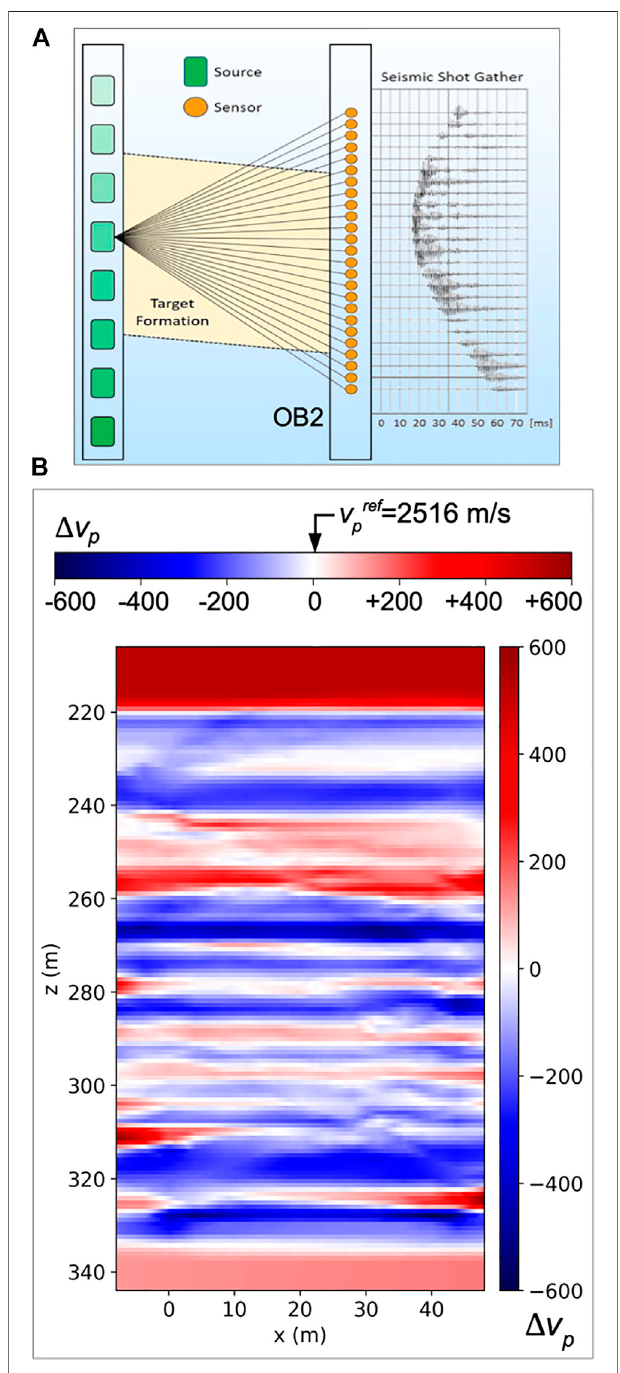
FIGURE 3 | (A) : Schematic view of crosswell seismic system. (B) : 2D v p -imageresultingfromCaMI.FRSseismic fi elddatainversion.Shownvelocity anomalies Δ v p are with respect to the reference velocity v ref p (cid:2) 2516 m/s.